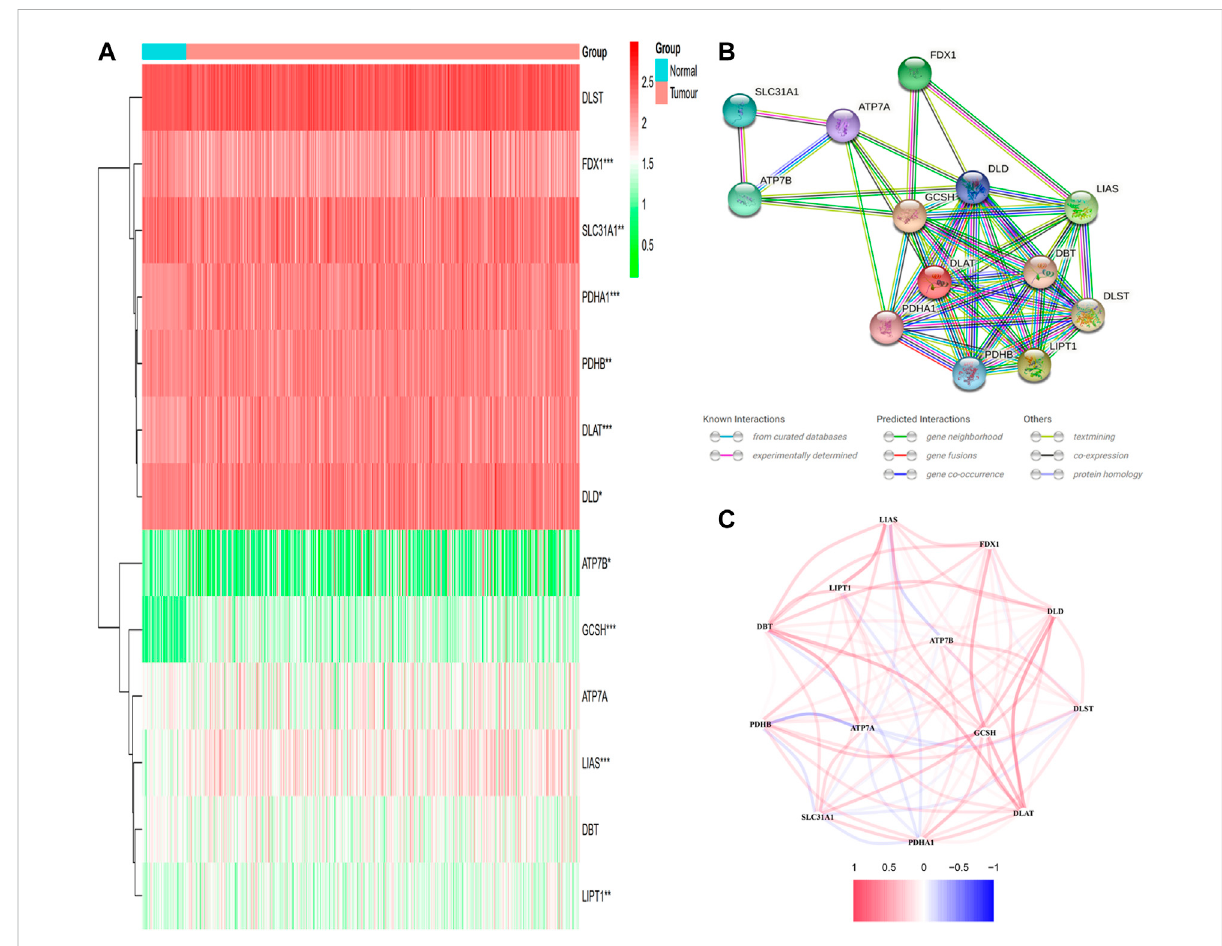
FIGURE 1 Theexpressionandinteractionsof13cuproptosis-relatedgenes. (A) Theexpressionofcuproptosis-relatedgenesinnormalandtumorsamples is shown in a heatmap (with green and red signifying low and high expression levels, respectively). Comparison between the tumor samples and the normal samples* p < 0.05;** p < 0.01; *** p < 0.001. (B) PPInetwork illustrating theconnectionsofgenesinvolvedincuproptosis(interactionscore = 0.15). (C) The network of genes associated with cuproptosis (red and blue lines depict positive and negative correlations, respectively). The strength of relevance is re fl ected in the intensity of the